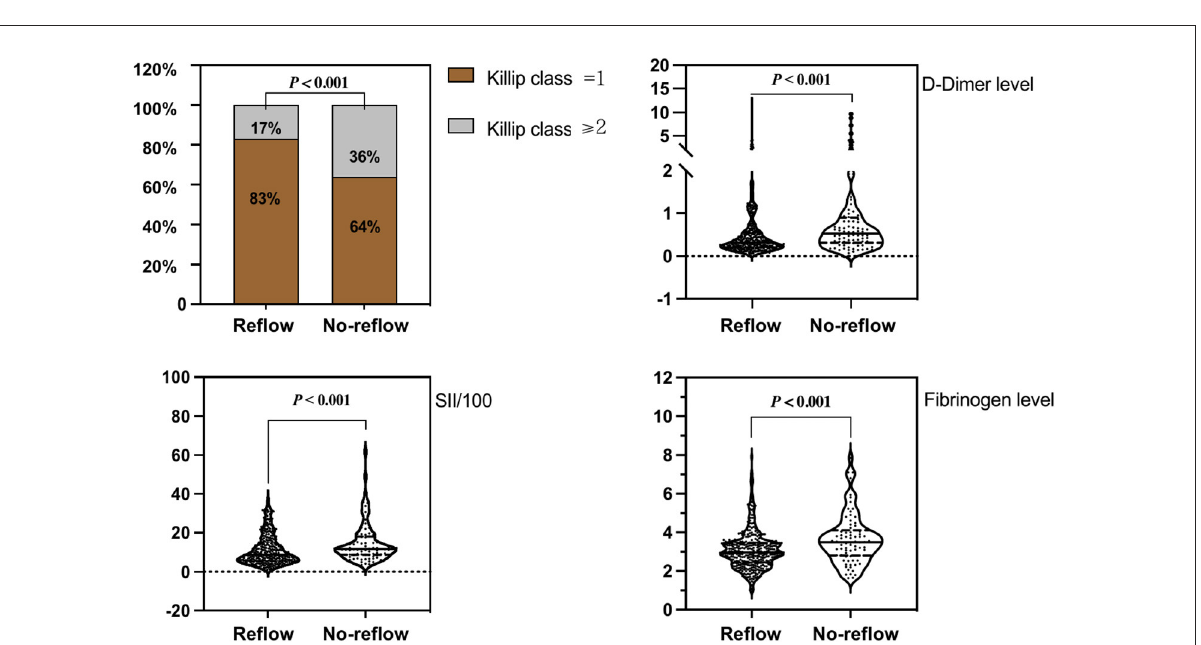
and Killip class on admission ( r = 0.306, P < 0.001), and fibrinogen level was positively correlated with Killip class on admission ( r = 0.130, P =